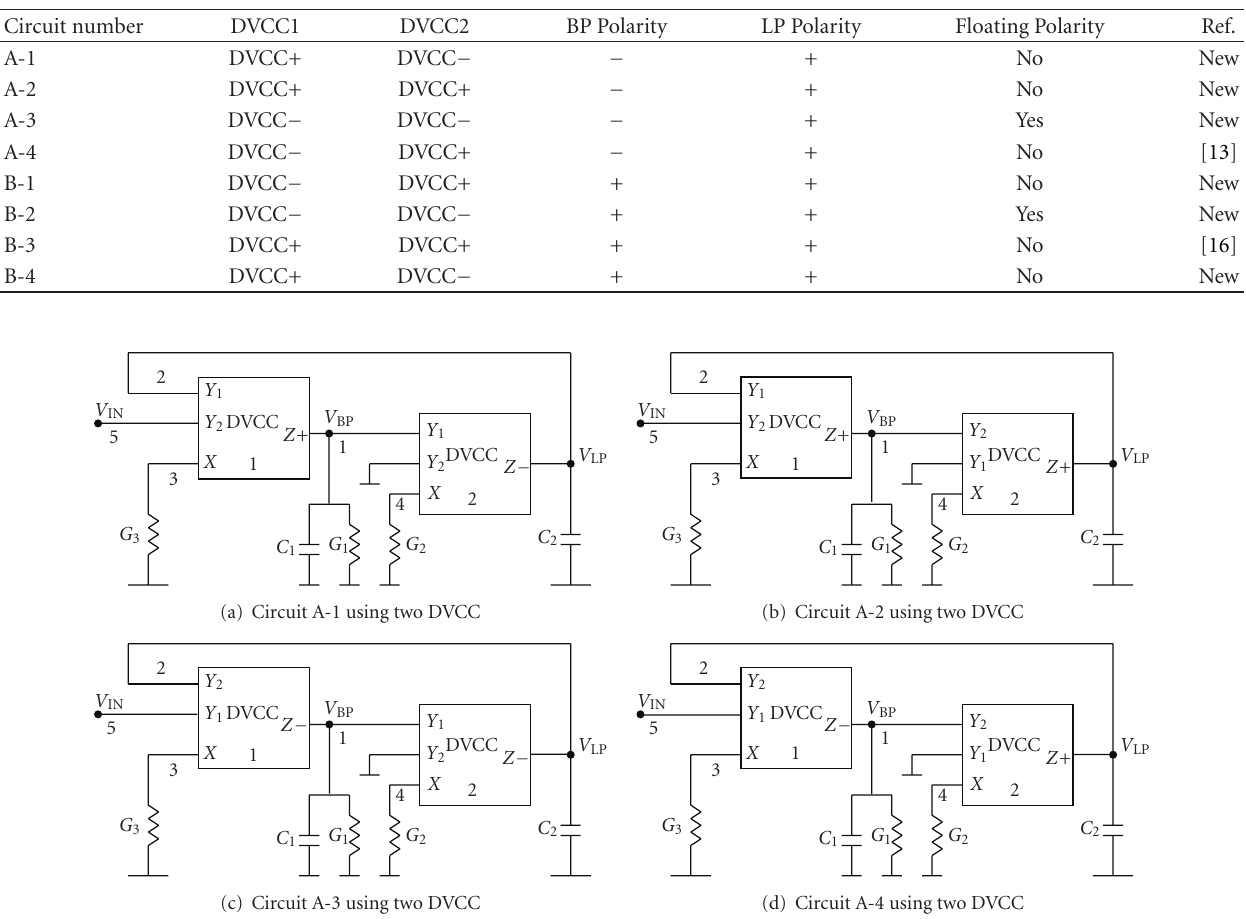
Table 2: Types of the DVCC used in the two integrator loop